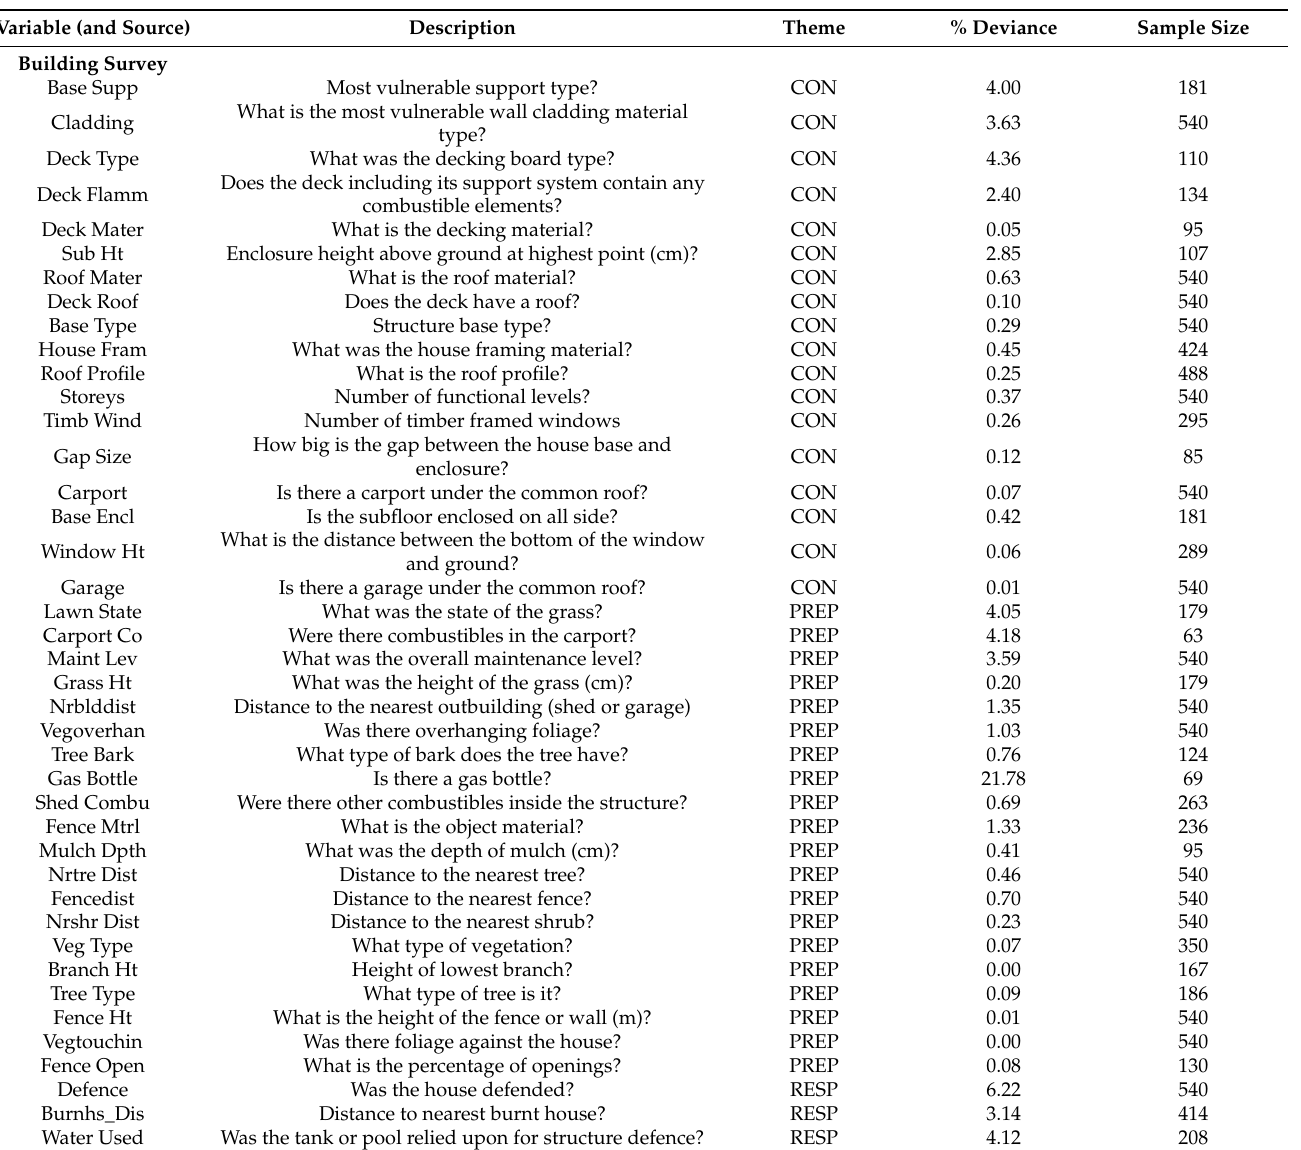
Table 1. The 84 attributes of houses used as predictor variables in the analysis, along with their source, associated theme, the number of houses with a value (n) and the percentage of deviance captured in a univariate binomial regression of house impact. Theme codes are PREP = preparedness action; RESP = response action; CON = construction; LF = landscape fuel; TOPO = topography; WEATH =